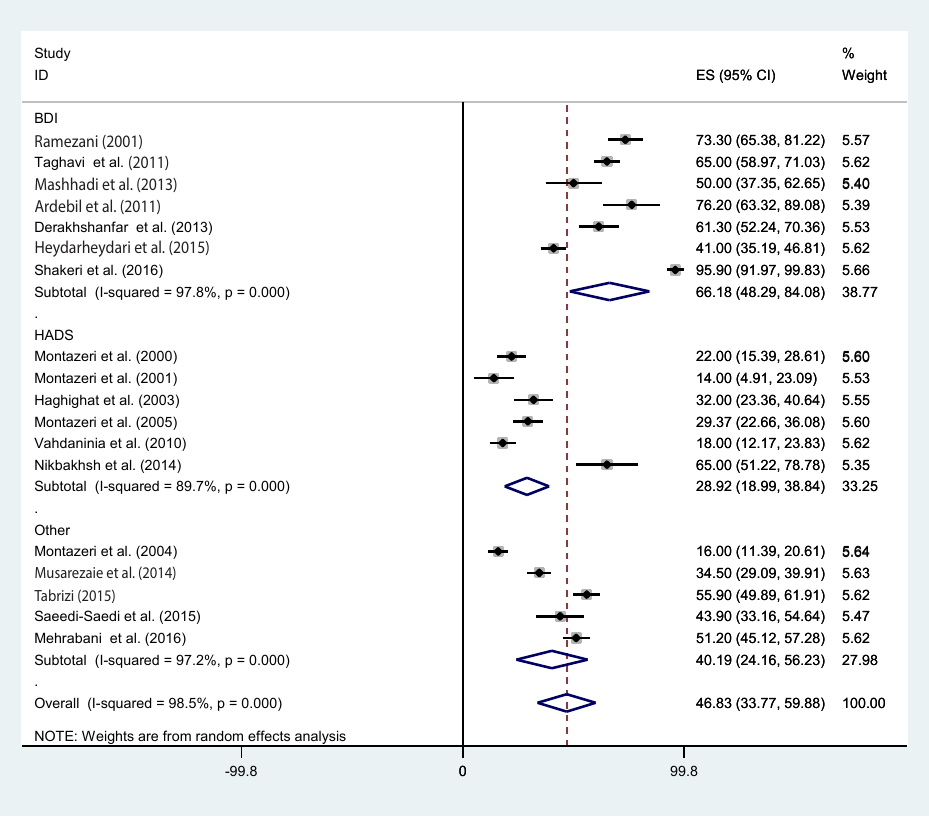
Figure 3. Prevalence of depression among Iranian breast cancer, Figure 2. Forest plot of all 18 studies included in the meta-analysis based on the depression showing an increase in prevalence from 2000 to 2018. assessment tool used.